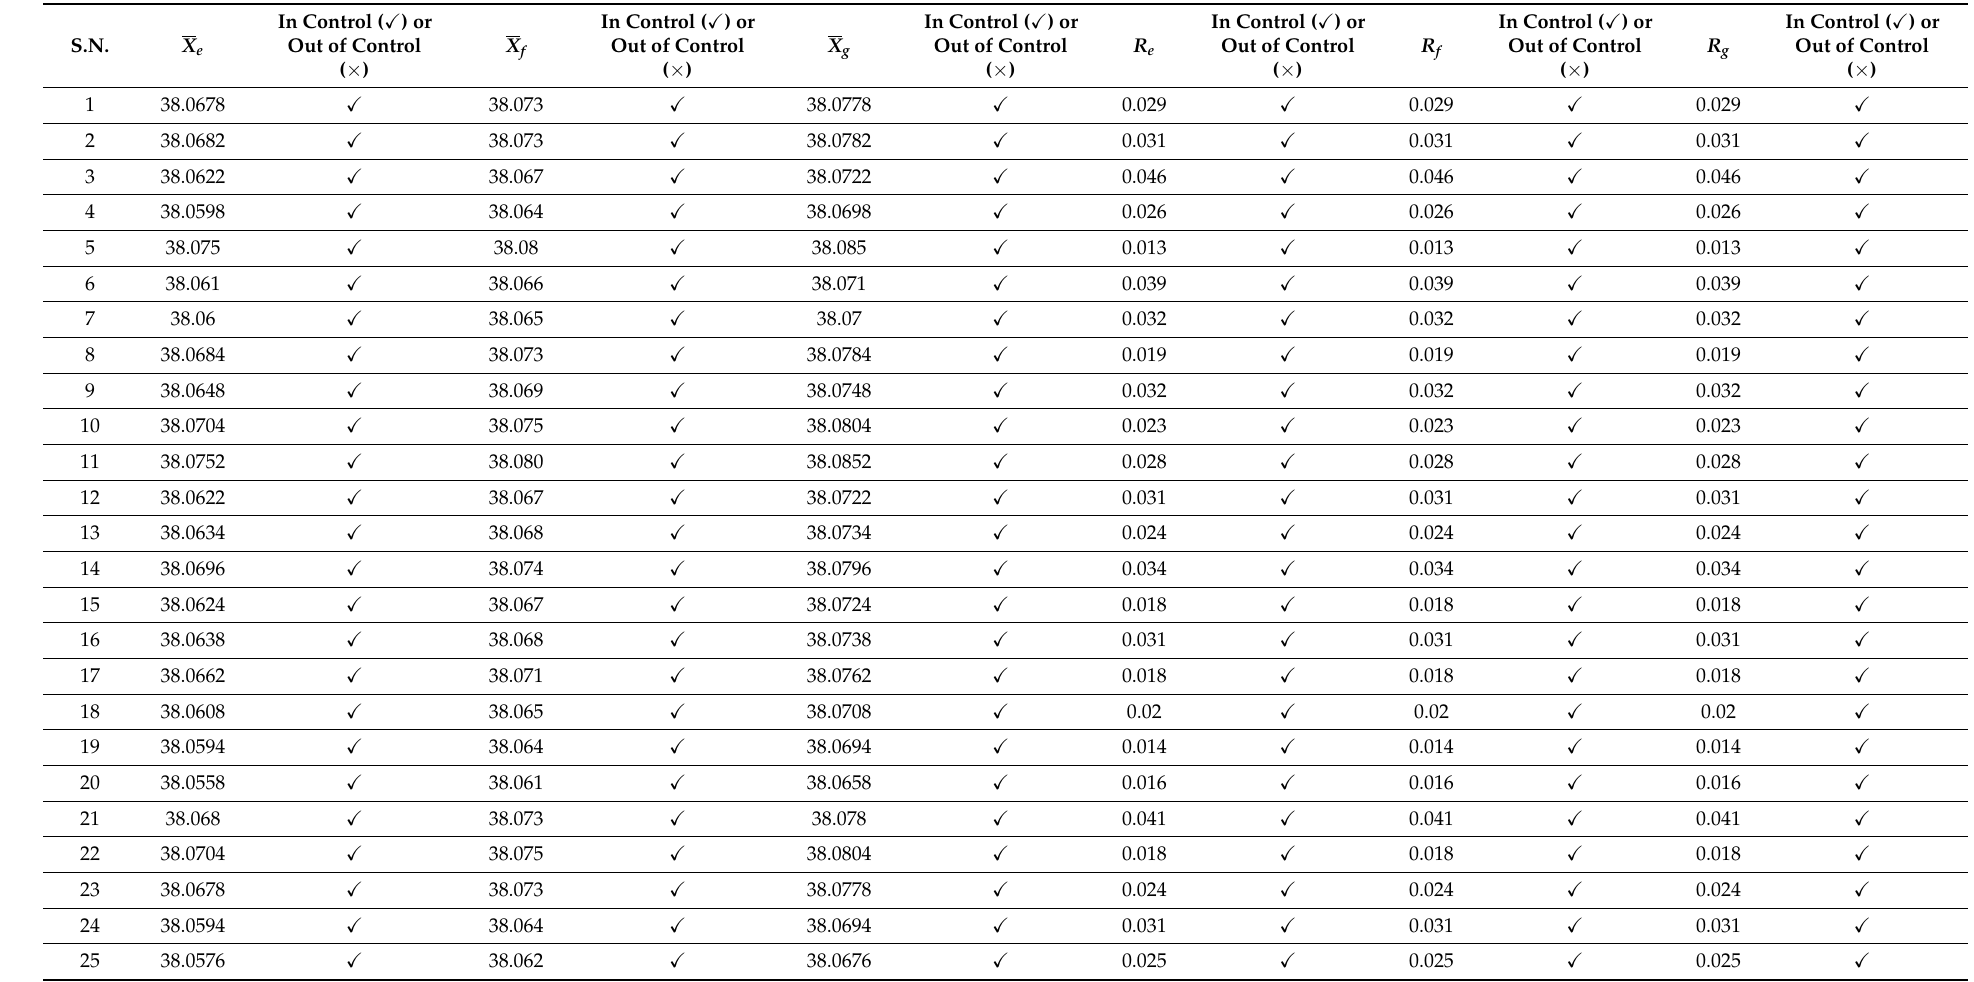
Table 6. Decision table for fuzzy X and R control limit with fuzzy C p